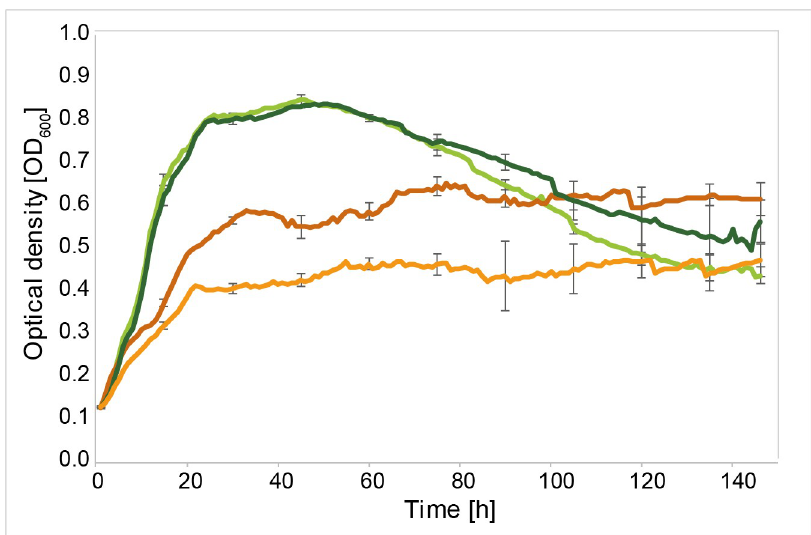
Fig 6. Growth of V . paradoxus TBEA6 and V . paradoxus Δ 05510. Growth was monitored at 600 nm. Cells were cultivated in MSM containing 60 mM succinate (TBEA6 (dark green); Δ 05510 (light green)) or 3,3´-thiodipropionate (TDP, TBEA6 (dark orange); Δ 05510 (light orange)) as the only carbon source. The experiment was done in triplicate; standard deviations are indicated as error bars.